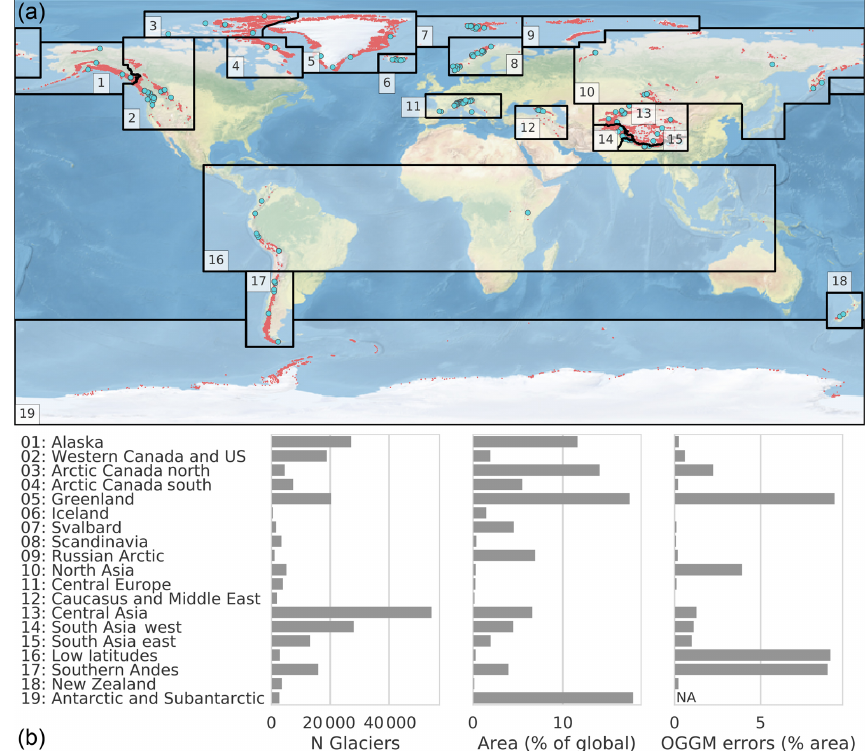
Figure C1. (a) Map of the RGI regions: the red dots indicate the glacier locations and the blue circles the location of the 254 reference WGMS glaciers used by the OGGM calibration. (b) Region names and basic statistics of the database (number of glaciers per region, regional contribution to the global area in percent, and the percentage of the regional area which cannot be modeled by